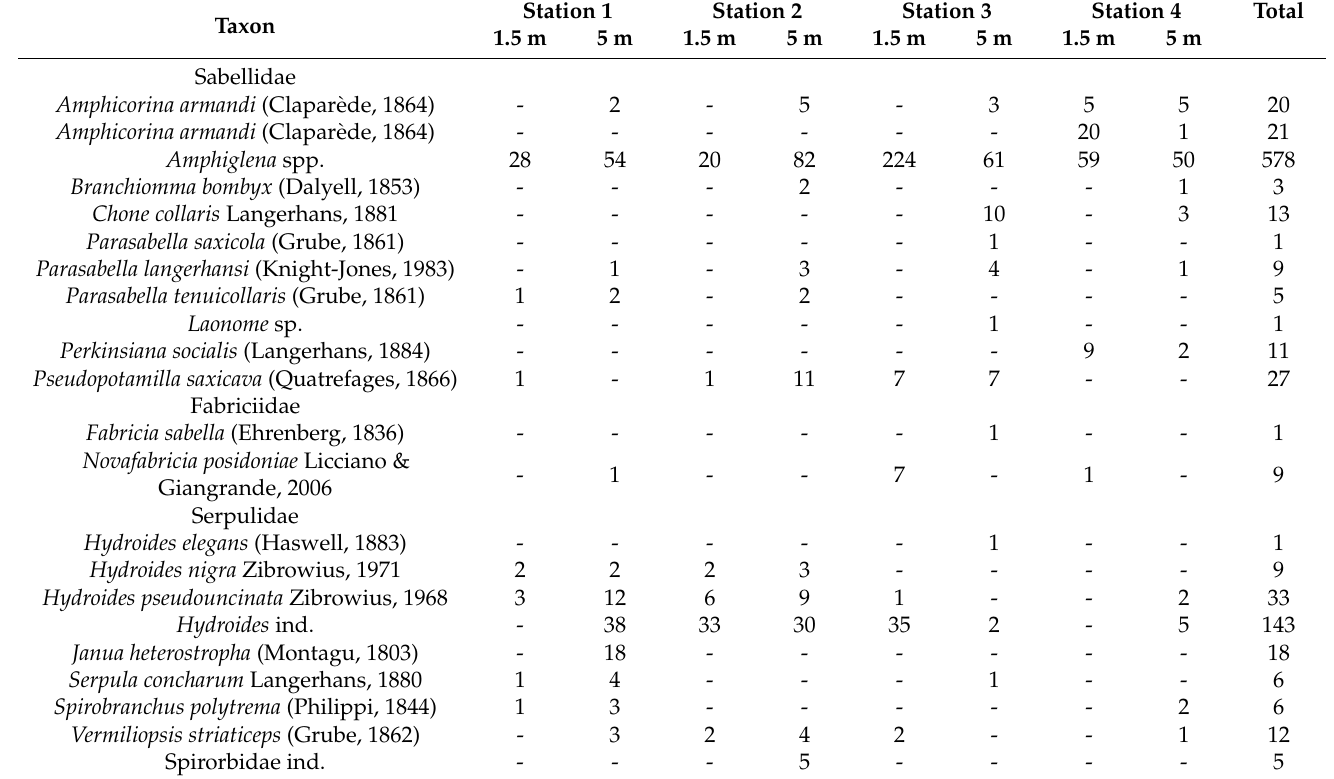
Table 1. Abundance of the species of Sabellida collected at Torre Guaceto